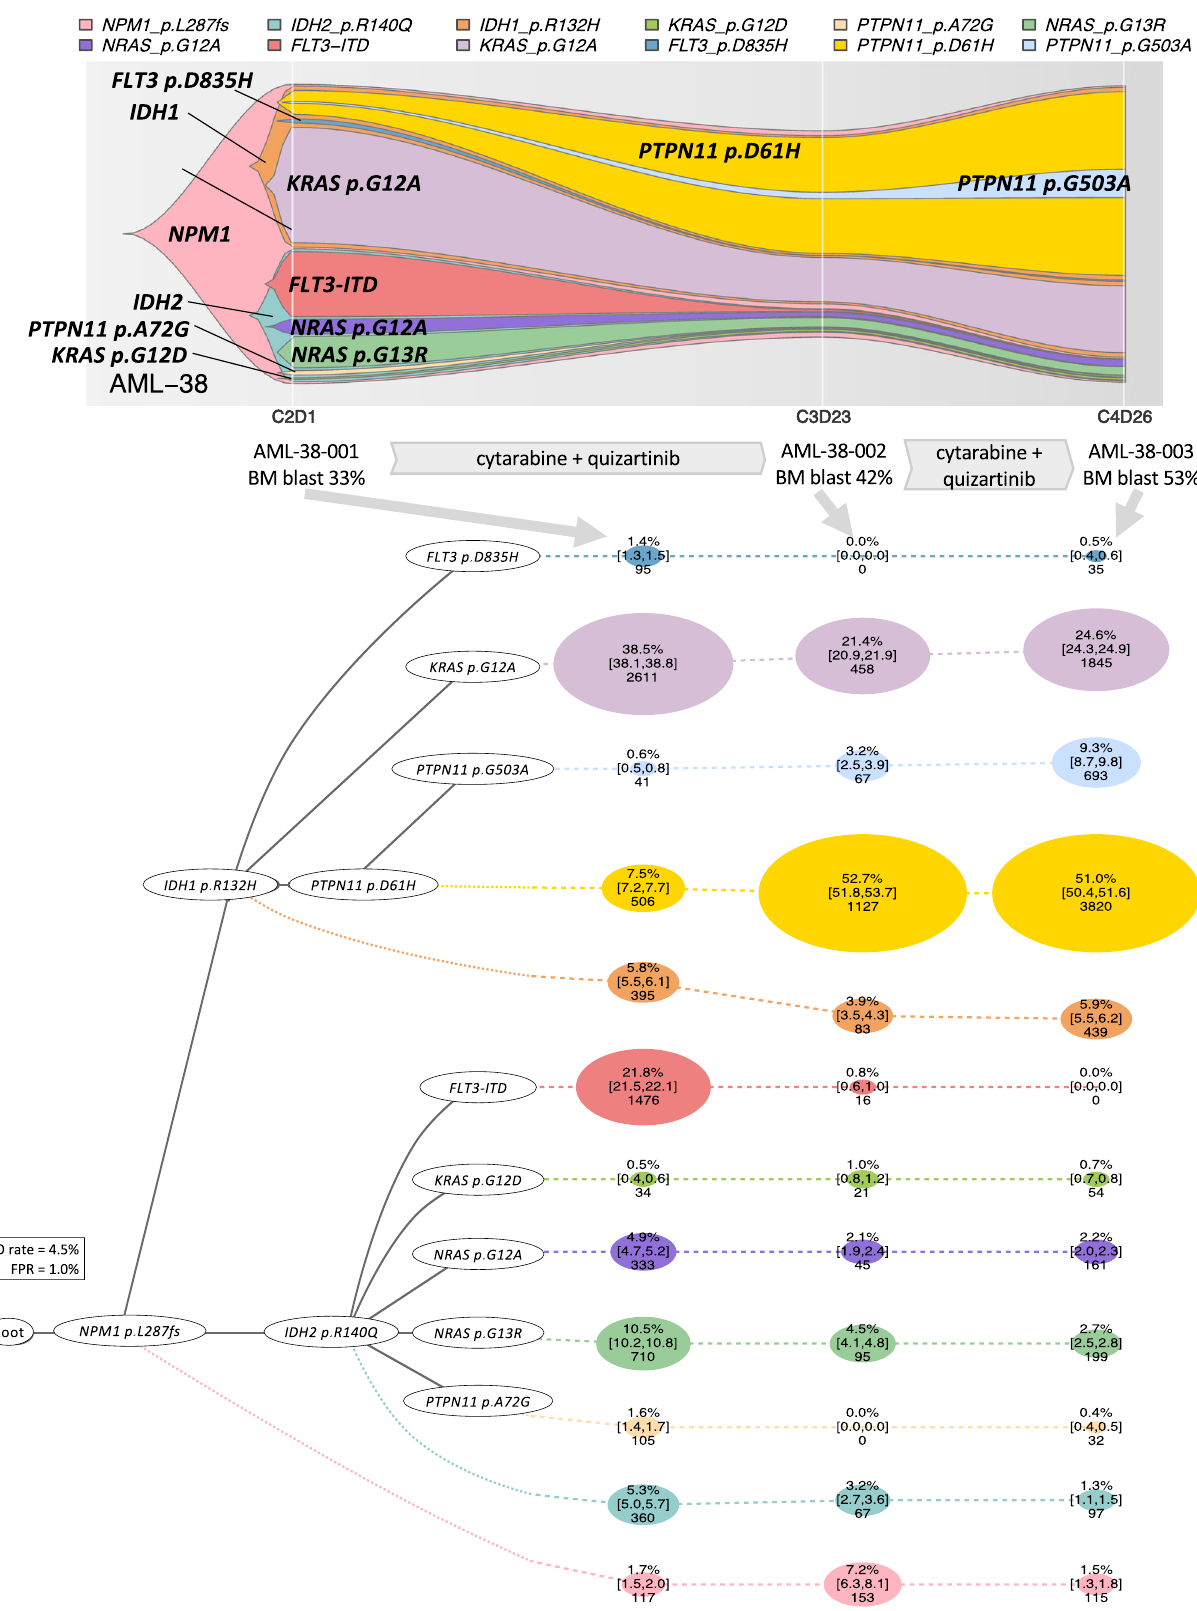
Fig. 8 Parallel evolution of RAS/PTPN11 clones during FLT3 inhibitor-containing therapy. A 58-year-old-man with refractory AML showing the clearance of FLT3 -ITD clone with an expansion of PTPN11/RAS clones during a FLT3 inhibitor-containing therapy. The fi sh plot shows the inferred clonal evolution pattern based on the single-cell genotype data. The phylogenetic trees visualize the estimated order of mutation acquisition and the proportion of subclones with a different combination of mutations at each timepoint. The wild-type cells which did not carry any driver mutations are not shown. C cycle, D day, ADO allele dropout, FPR false-positive rate. Full case description is available in Supplementary